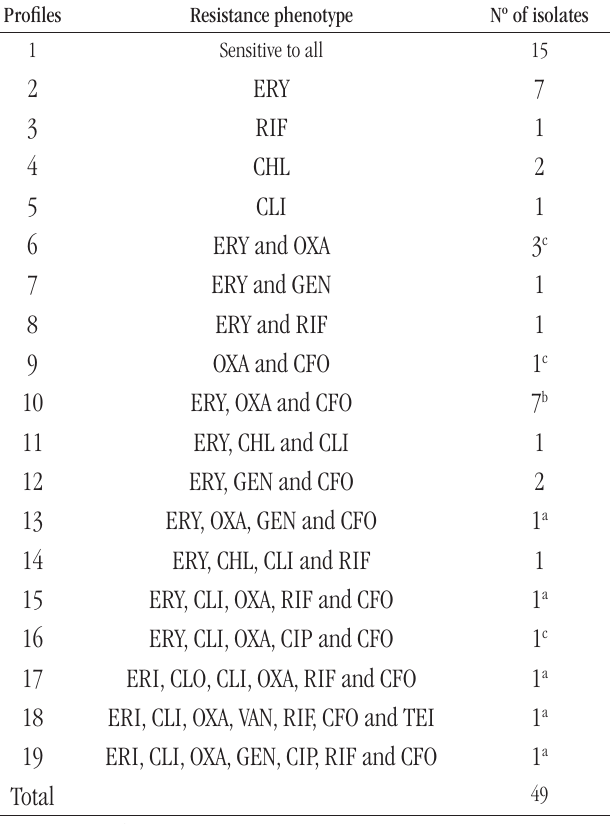
taBLE 2 – Antimicrobial resistance profiles of Staphylococcus spp. isolates